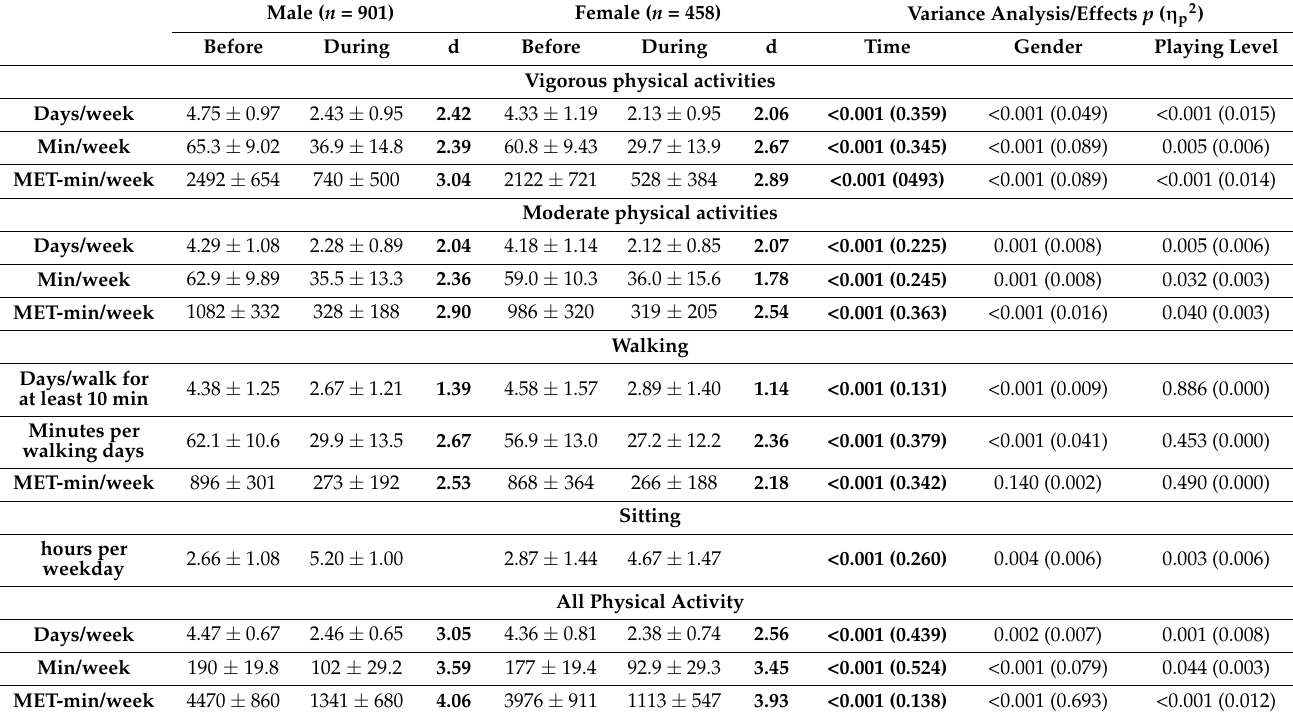
Table 6. Comparison of physical activity parameters between male and female before and during confinement (control variable: playing level). Values are given as mean ± SD. Meaningful effects (criteria: p < 0.05 and η p2 > 0.10 and d > 0.8) are highlighted in